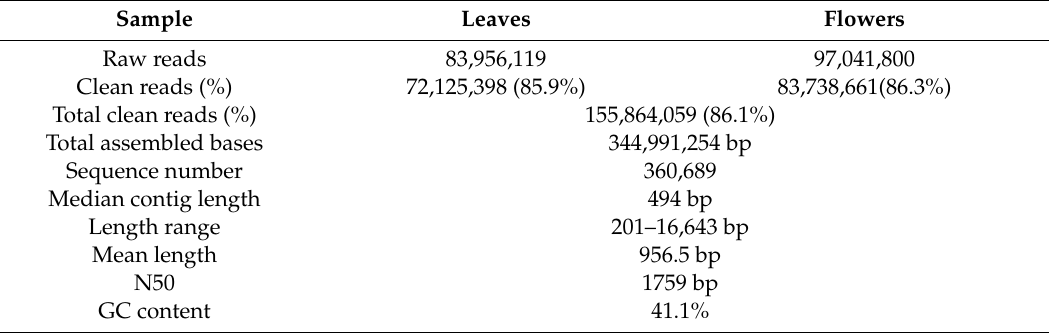
Figure 1. Plant material of O. dubium line 5 and its total carotenoid content in leaves and mature flowers ( a ), and the transcriptome sequence information for leaves and flowers of O. dubium line 5 ( b , c ). ( b ) The distribution of assembled O. dubium contigs by length. ( c ) Venn diagram of the distribution and similarity of O. dubium contigs, in comparison with sequences from The Arabidopsis Information Resource (TAIR), non-redundant proteins (NR) and rice protein databases. Table 1. Raw and clean reads for leaves and combined flowers of O. dubium line